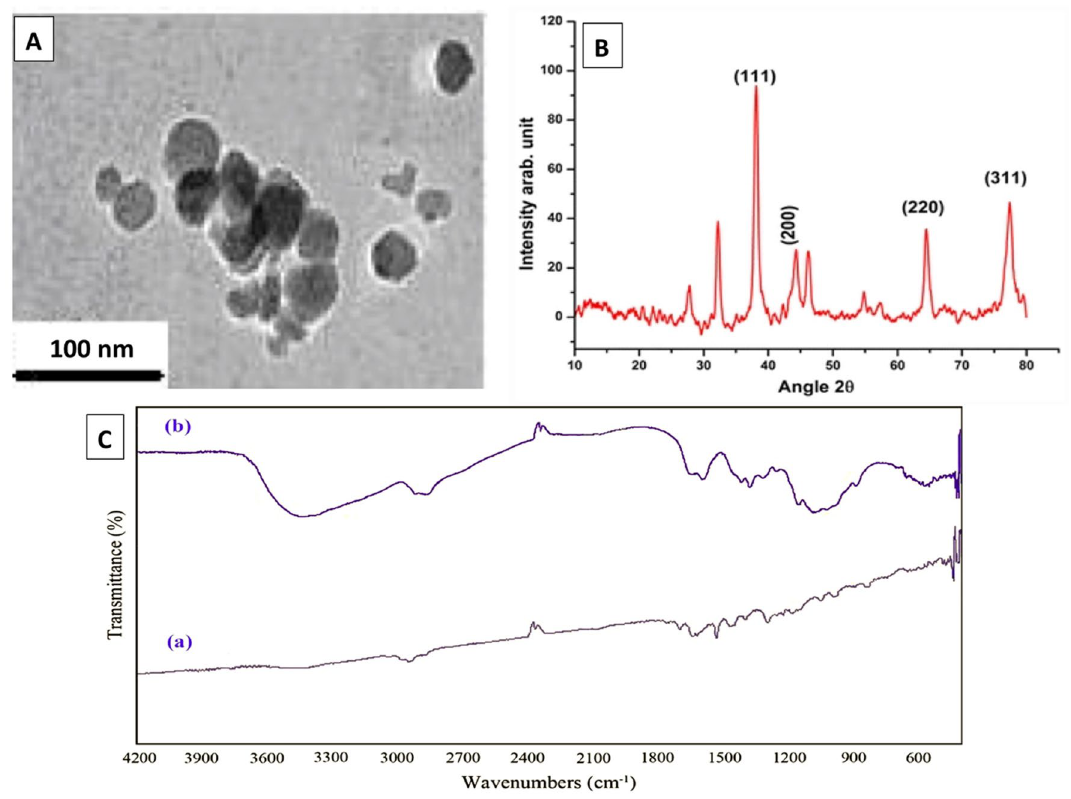
Figure 1. Characterization of synthesized silver nanoparticles (AgNPs). ( A ) The TEM image of AgNPs showed a spherical particles with size in nano range (10–50 nm, ( B ) X-ray diffraction analysis revealed the crystalline structure of AgNPs, ( C ) The FTIR analysis was done for AgNPs in the range of 400–4000 cm −1